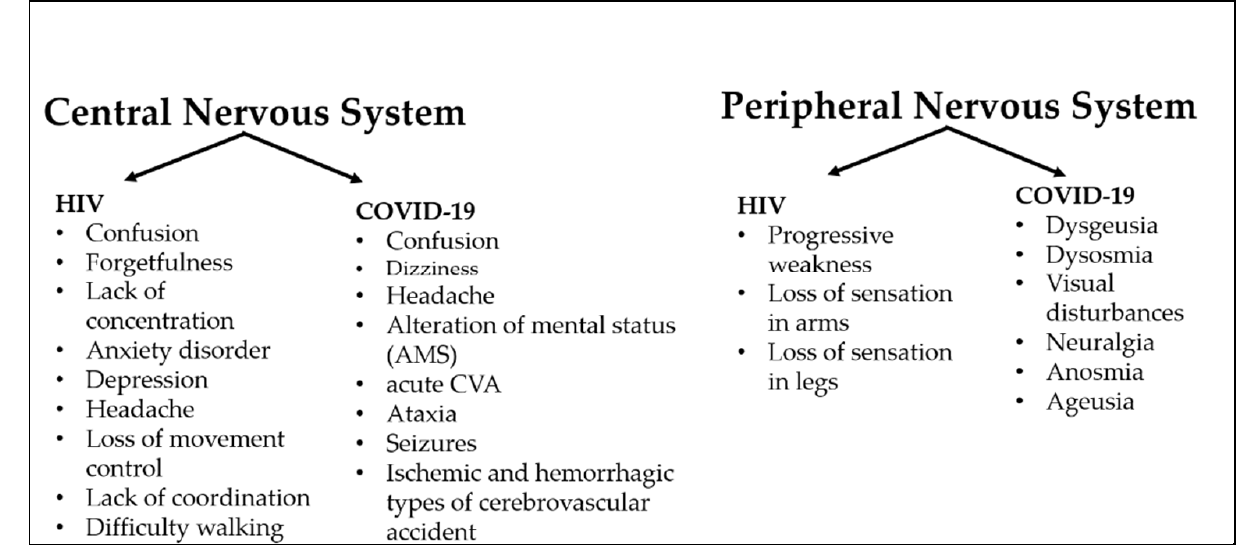
Figure 1. Major reported neurological complications associated with HIV and COVID-19.